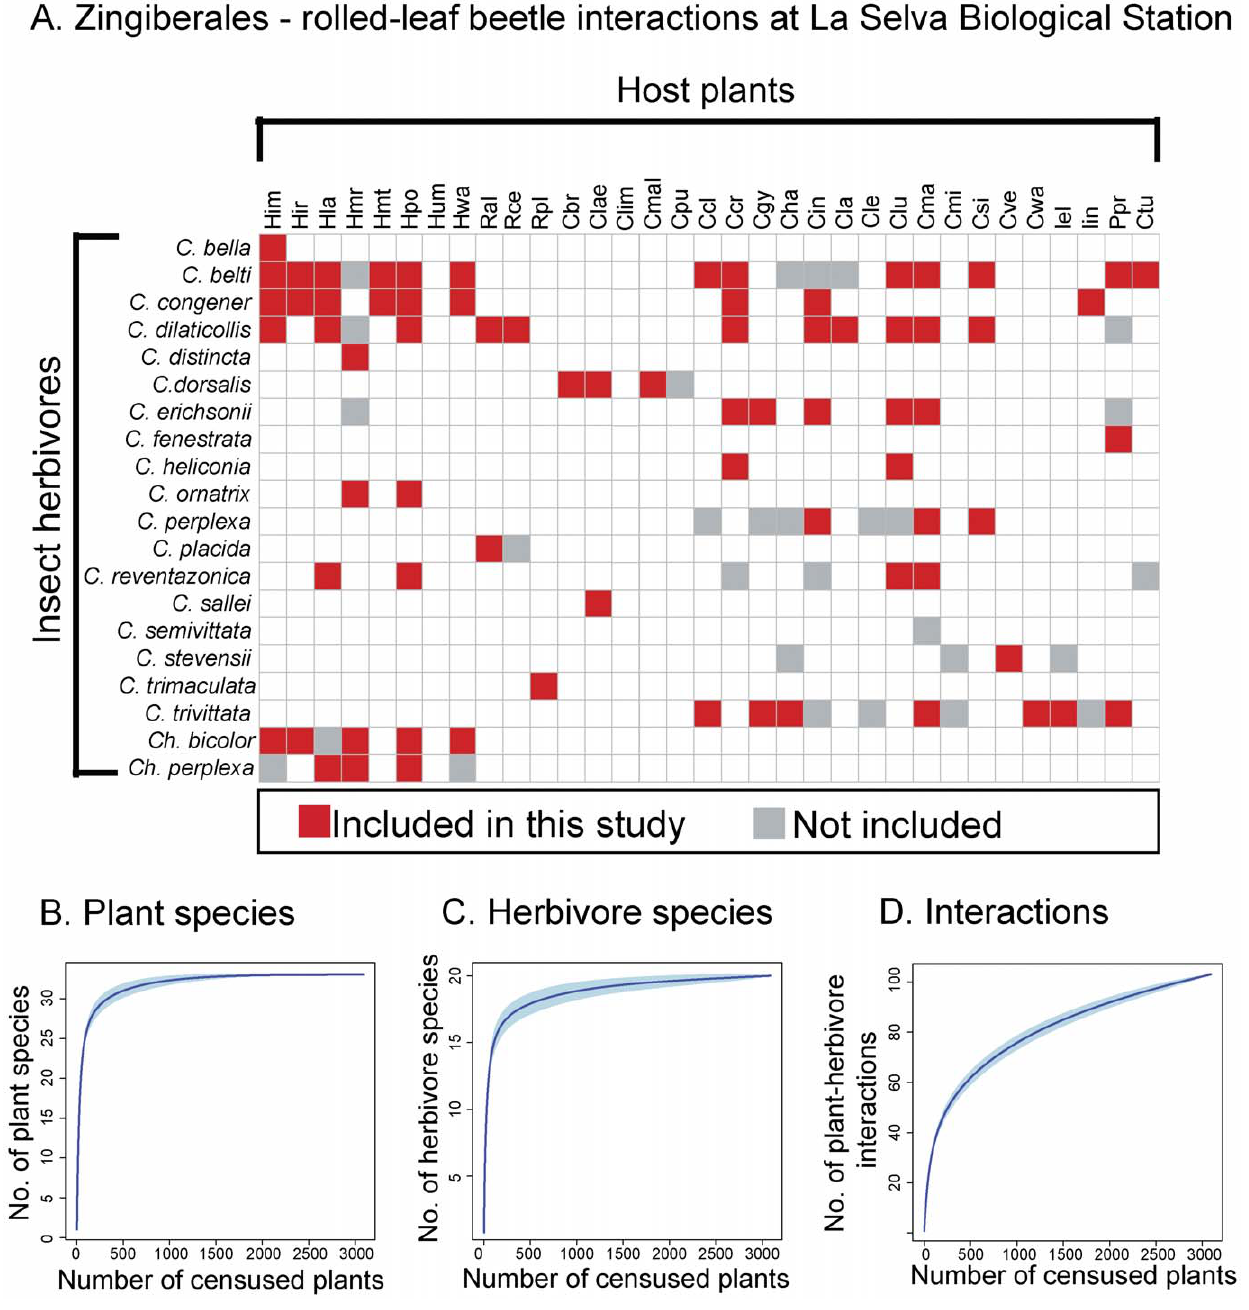
Figure 2. A comprehensive survey of rolled-leaf beetles and their associations with Zingiberales at La Selva Biological Station, Costa Rica. A . Interactions recorded for two years during rainy and dry seasons (October 2008 - February 2009 and October 2010– February 2011). Each matrix element represents an association between an insect herbivore species (rows) and a host plant species (columns). Interactions in red were recorded during the second year of this study and selected for diet analyses. B . Sampling effort and accumulation curves of plant and insect herbivore species and their interactions at La Selva (Mean 6 SD). Total number of host plants censused=3092. Total number of insect herbivore records=7359. Host plant species abbreviations: Heliconiaceae. Him= Heliconia imbricata . Hir= H. irrasa . Hla= H. latispatha . Hmr= H. mariae . Hmt= H. mathiasiae . Hpo= H. pogonantha . Hum= H. umbrophila. Hwa= H. wagneriana . Zingiberaceae. Ral= Renealmia alpinia . Rce= R. cernua . Rpl= R. pluriplicata . Costaceae. Cbr= Costus bracteatus . Clae= C. laevis . Clim= C. lima . Cmal= C. malortieanus . Cpu= C. pulverulentus. Marantaceae. Ccl=